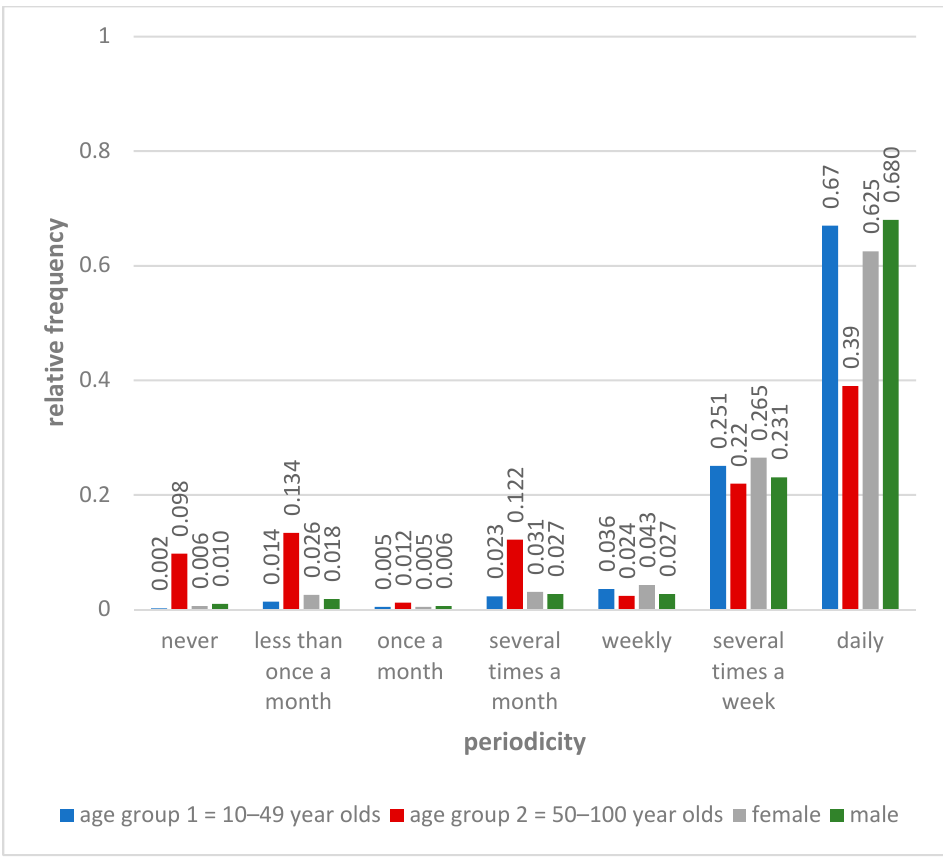
Figure 1. Viewing of VoD content by age (N = 1258) and gender (N = 1253) (relative frequencies). Question: How often do you watch videos (movies, TV shows, and videos on the Web)